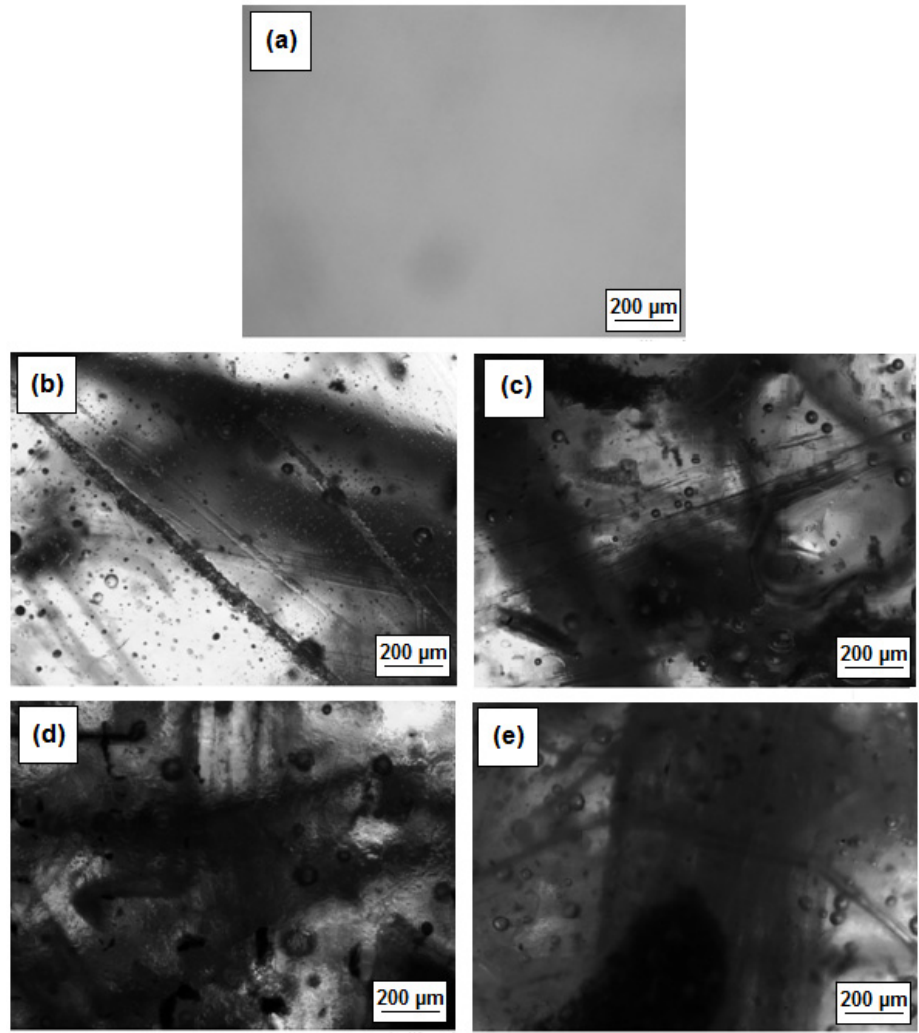
Figure 3. Microphotographs of the composites ( a ) sample without eco-filler; ( b ) sample with 5 wt.% of eco-filler; ( c ) sample with 10 wt.% of eco-filler; ( d ) sample with 20 wt.% of eco-filler; and ( e ) sample with 30 wt.% of eco-filler. Magnification 5×.